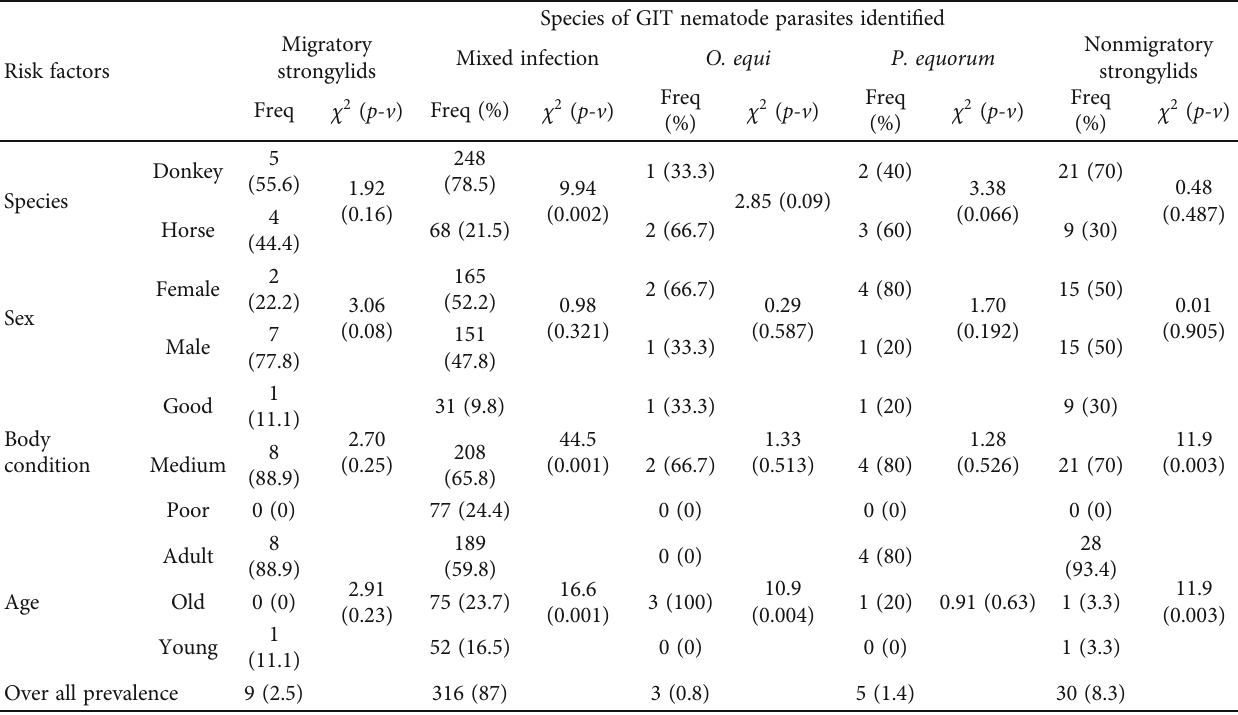
Table 3: Species wise prevalence and their associated risk factors for the occurrence of GIT nematodes in